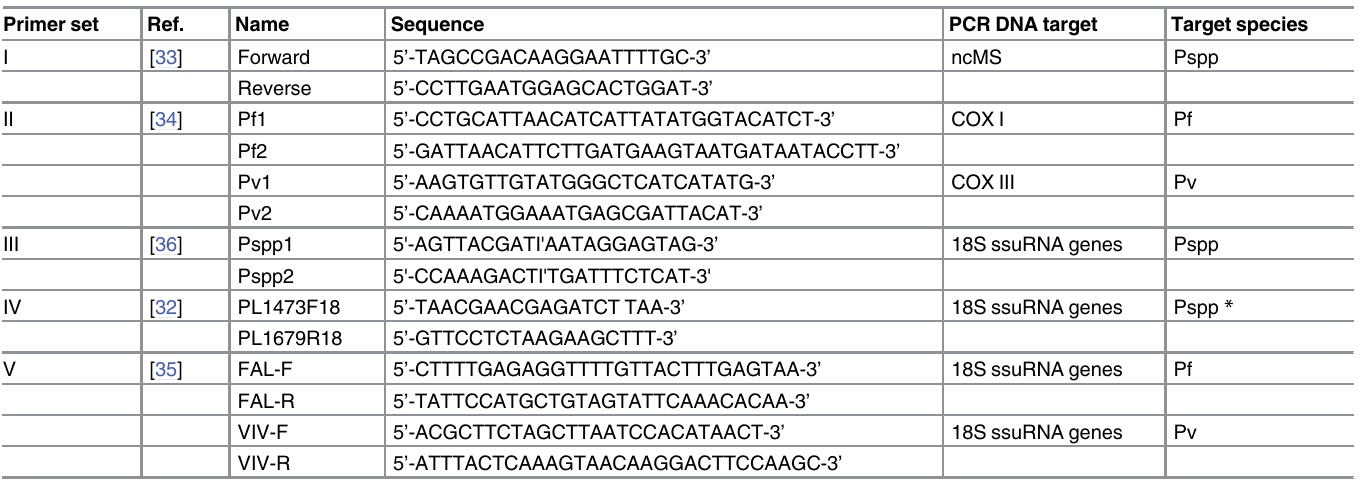
Table 1. Sequences of the primers used in the study and corresponding references. Primer set